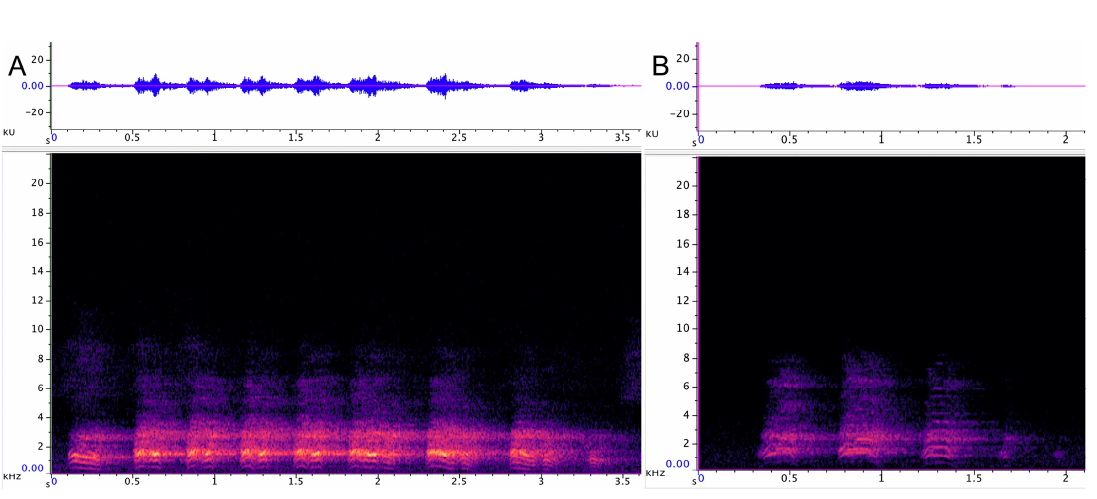
Figure 8 Figure 7. Otolemur calls (upper images: waveform, lower images: spectrogram). ( A ). Trailing call is a primary advertisement call (Sound S13). This call has nine subunits where intensity first grows and then trails away. ( B ) Cluster squawk is a contact call, and may be used to answer trailing calls (Sound S14). It is also used as a mild alarm with subunits further apart with high repetition